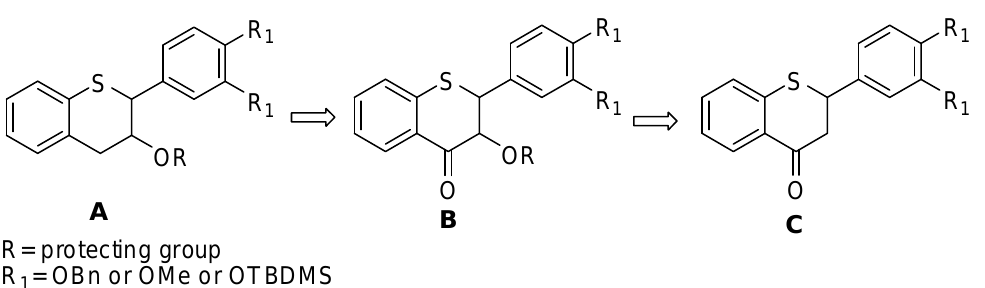
Figure 3. Initial retrosynthetic approach.